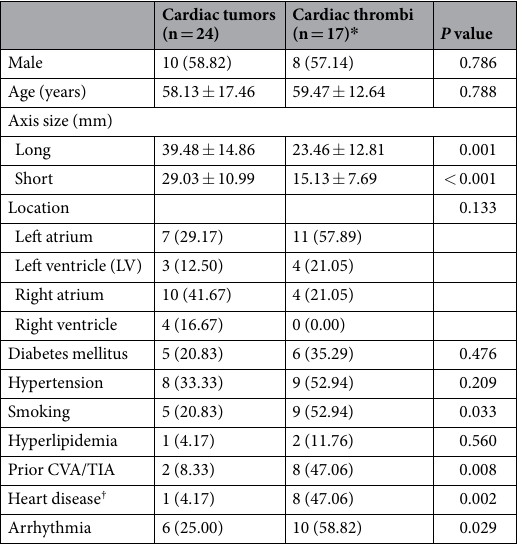
Table 1. Demographic and baseline characteristics of patients. Note: Values are given as mean ± SD, Data in parentheses are percentages. * As two patients each had two thrombi, 17 patients were included in the demographics and 19 lesions were included in the location analysis. † Heart disease includes valvular heart disease and myocardial infarction. CVA, cerebrovascular accident; TIA, transient ischemic